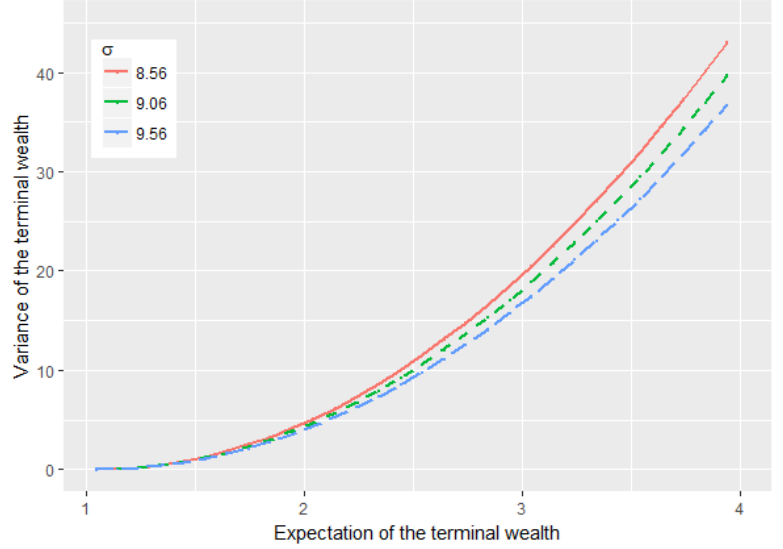
Figure 4. The impact of σ on the efficient frontier.